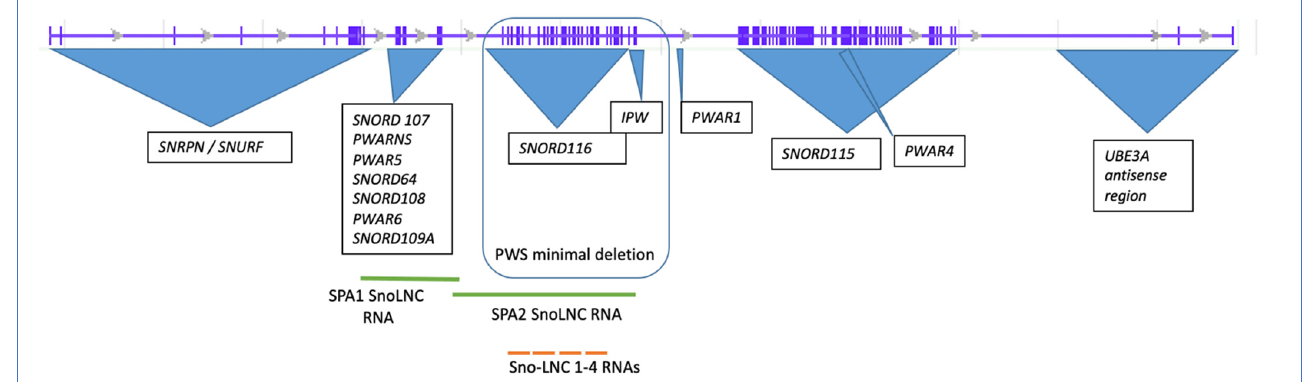
Figure 1. Structure of the human SNHG14 host gene and associated loci. The initial intron/exon structure of the host gene was obtained from the UCSC browser database, ENST00000656510.1). The minimal deletion that still results in PWS is outlined.